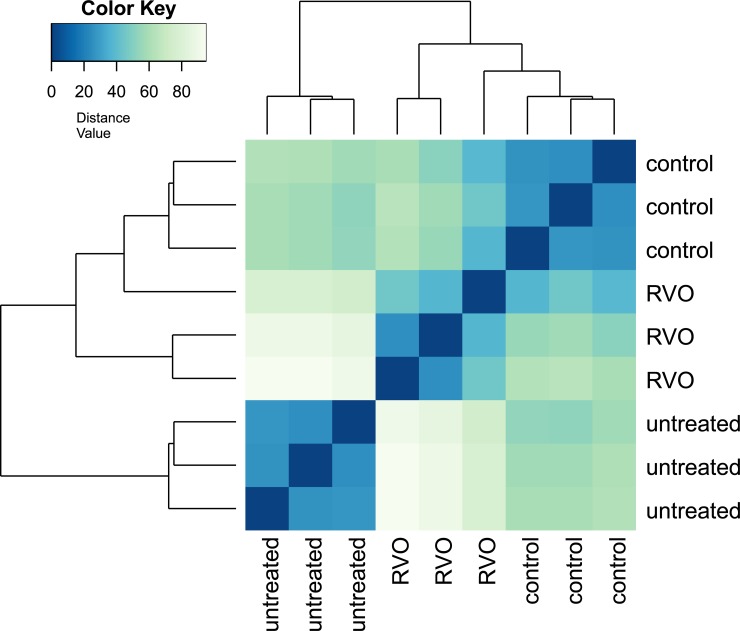
Sample-to-sample distances.